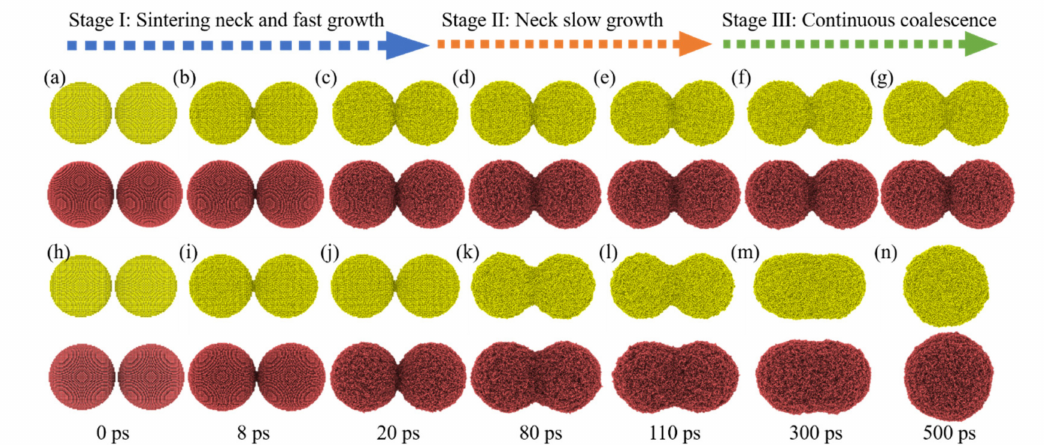
Figure 7. EPs morphological changes during the sintering process corresponding to sintering time. ( a – g ) Premelting sintering process (sintering temperature is 1000 K) and ( h – n ) liquid-phase sintering process (sintering temperature is 1100 K). The EPs-8 atoms are colored yellow and EPs-12 atoms are colored